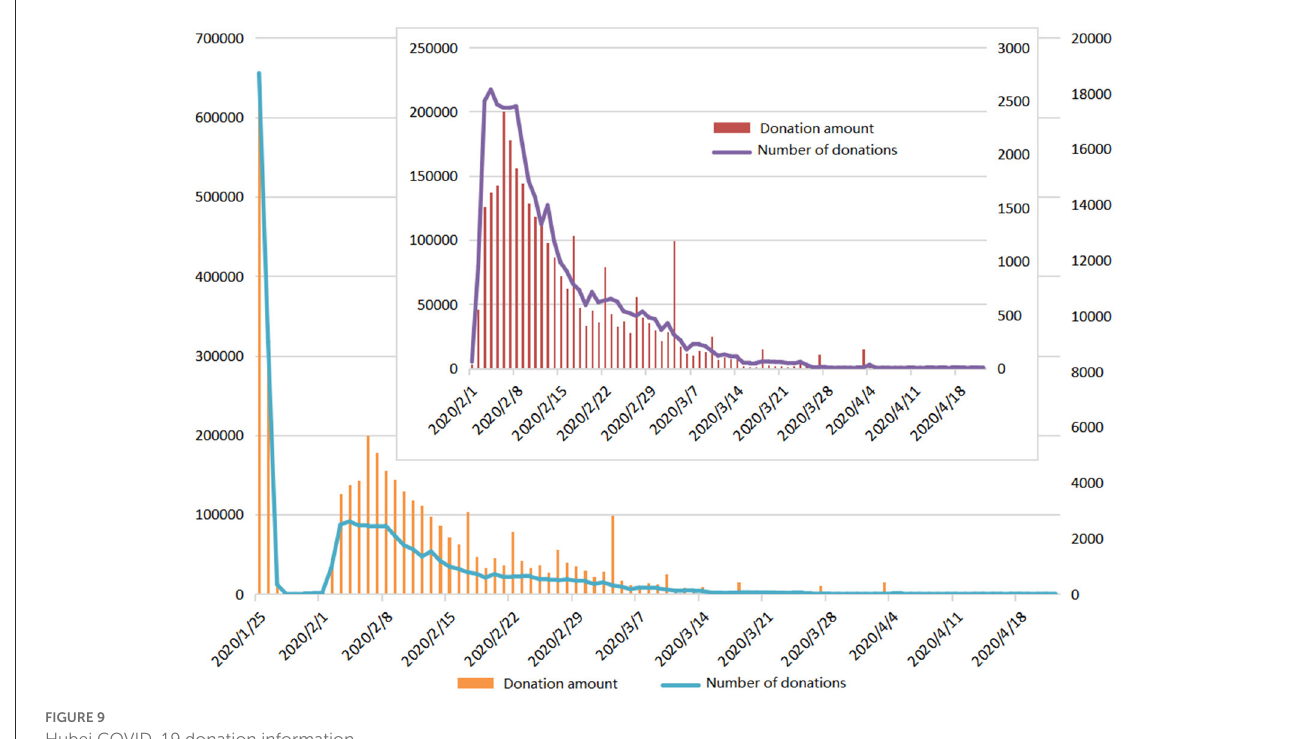
FIGURE9 Hubei COVID-19 donation information.